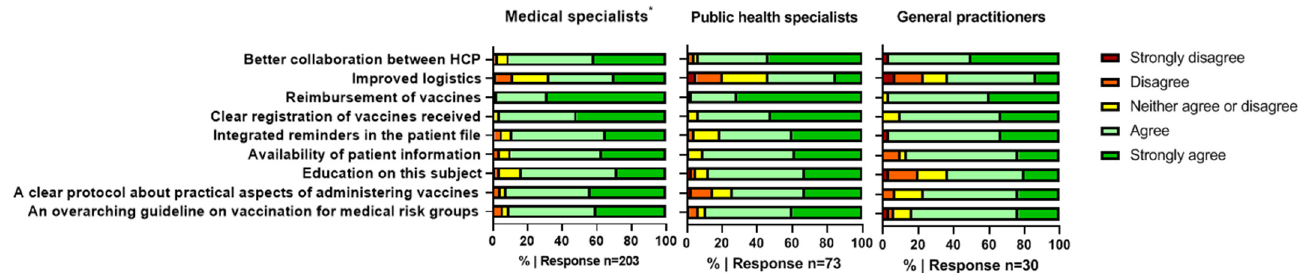
Figure 2. Interventions to overcome barriers to indicating medically indicated vaccines. * Including physician assistants and nurse practitioners. physician assistants and nurse